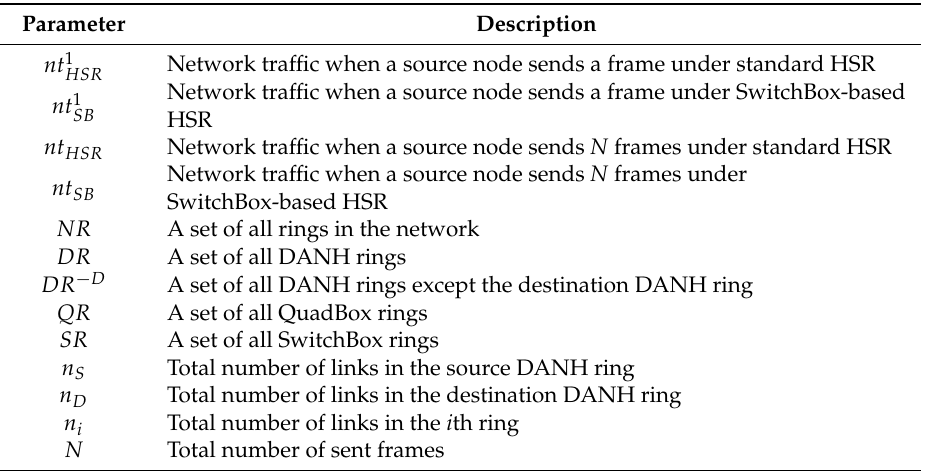
Table 1. Parameters for network traffic performance analysis.